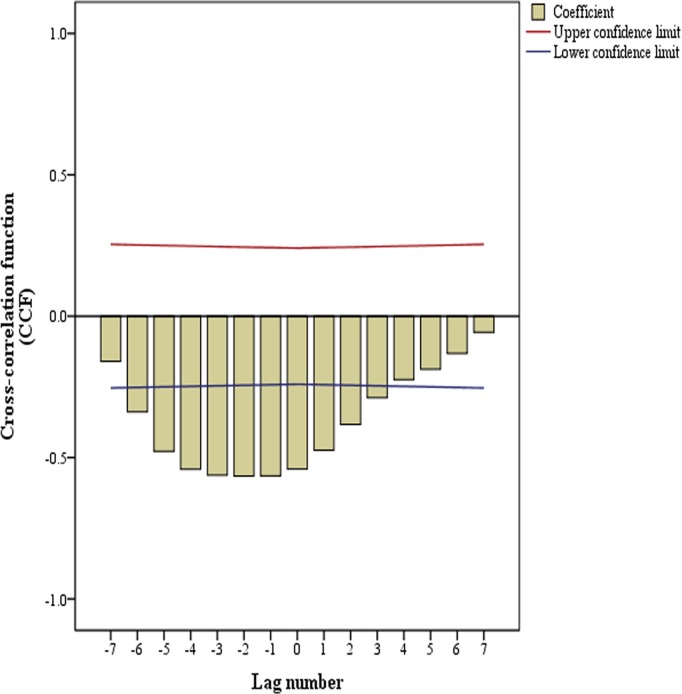
Cross-correlation coefficients of Yt and Xt+i.